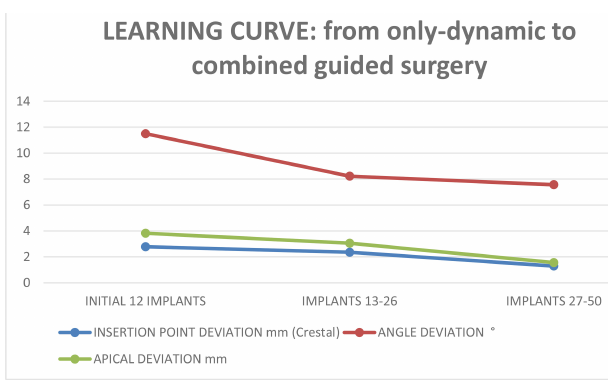
TABLE 6 | Learning curve, from the initial jig dynamic navigation to combined, static-dynamic-AR, guided